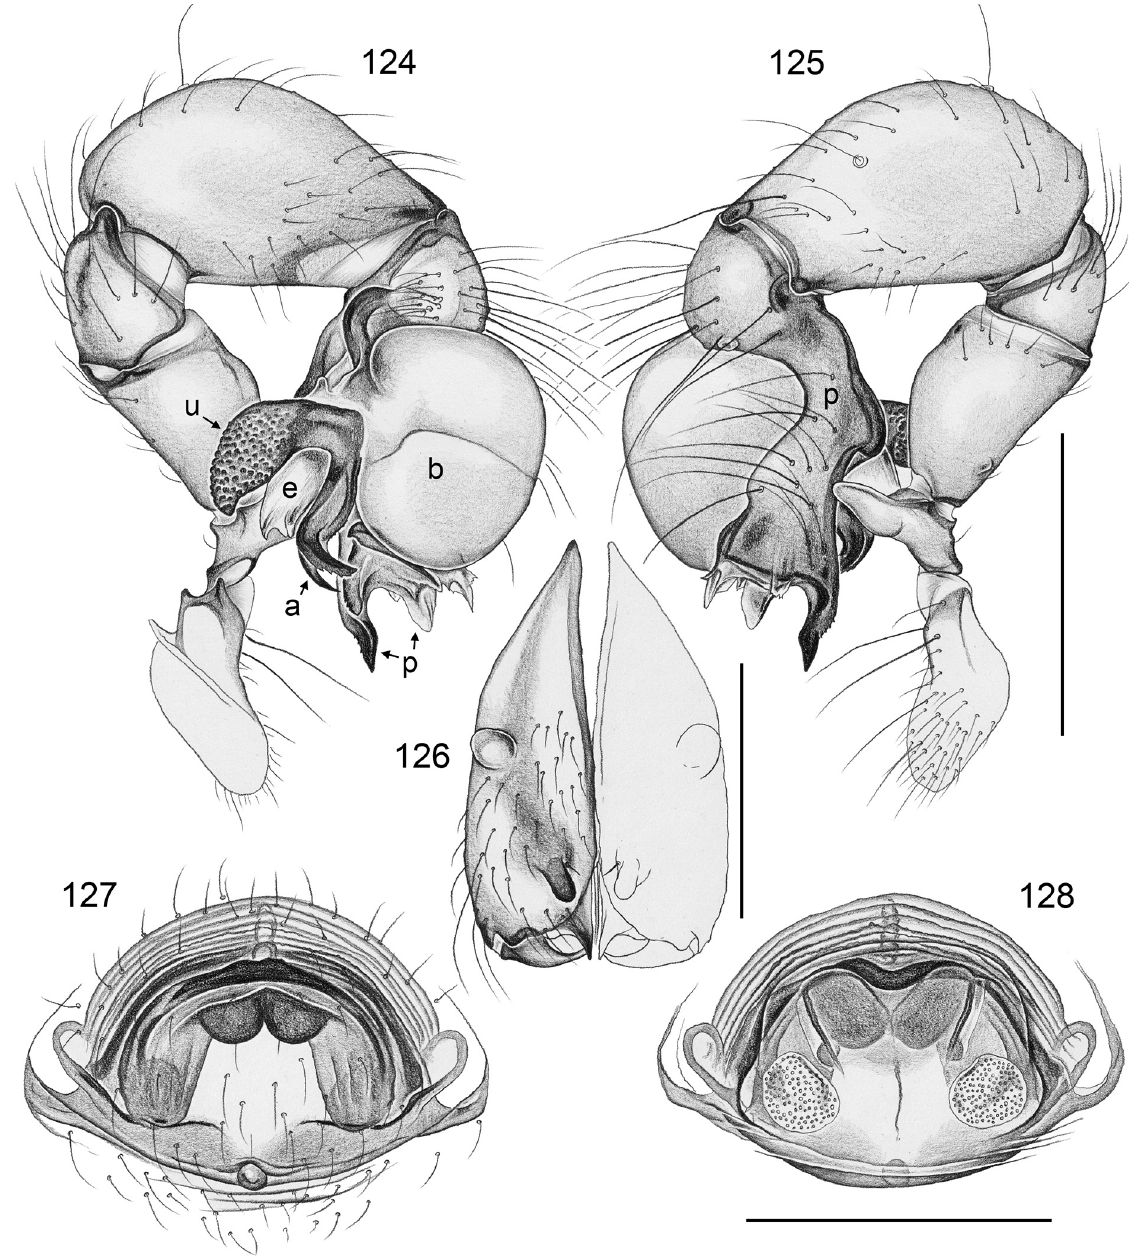
Figs 124–128. Pholcus narathiwat Huber, sp. nov., ZFMK Ar 15041. 124–125 . Left male palp, prolateral and retrolateral views. 126 . Male chelicerae, frontal view. 127–128 . Cleared female genitalia, ventral and dorsal views. Abbreviations: a = appendix; b = genital bulb; e = embolus; p = procursus; u = uncus. Scale lines: 0.3 mm (126), 0.5 mm (124–125,